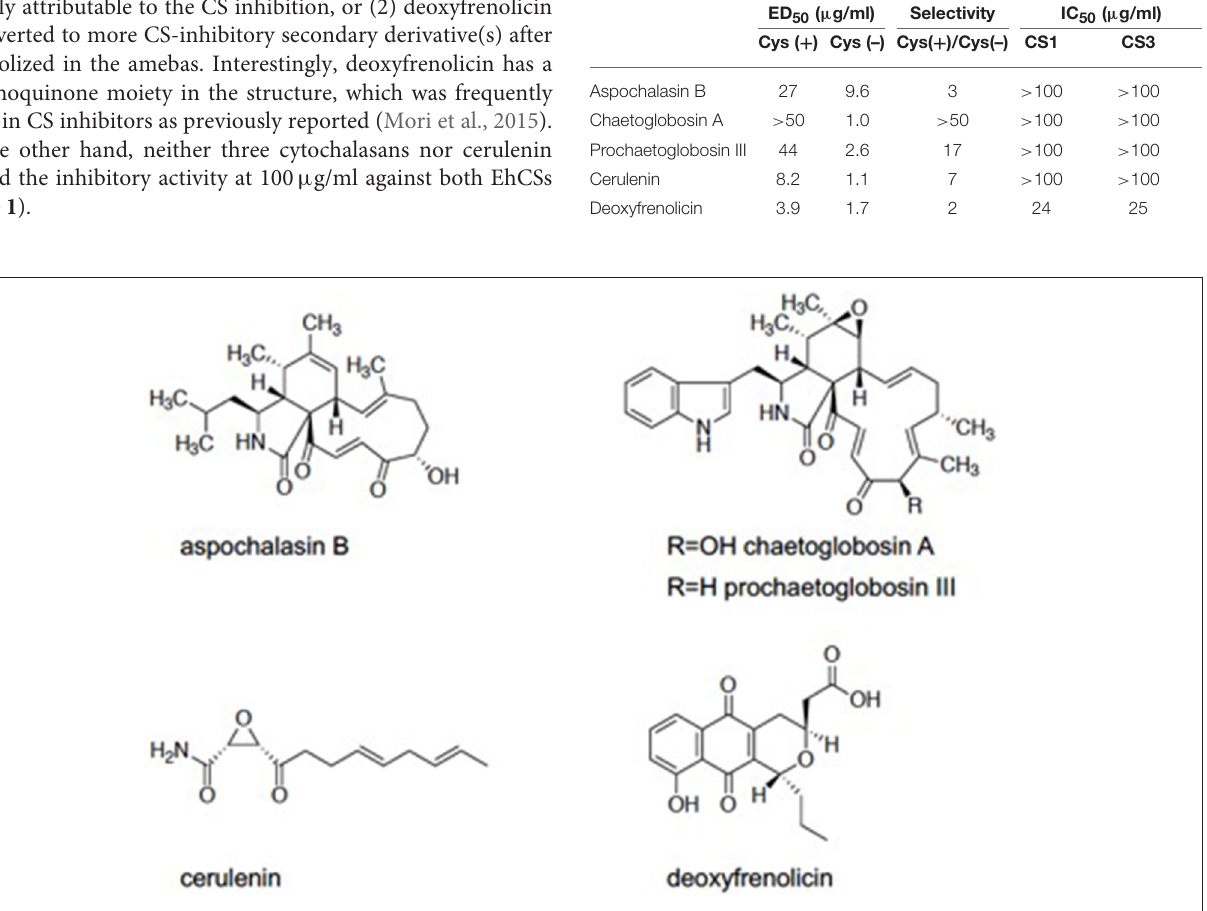
TABLE 1 | CS inhibitory activity and anti-amebic activity of five compounds screened from Kitasato Natural Compounds Library. Compounds